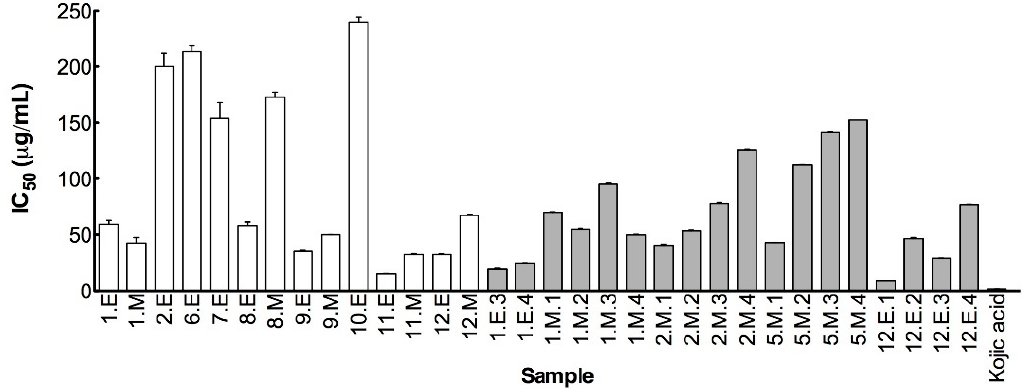
Figure 7. Tyrosinase inhibition activity (IC 50 values) by the extracts (light bars) and fractions thereof (dark bars). Reference: Kojic acid.